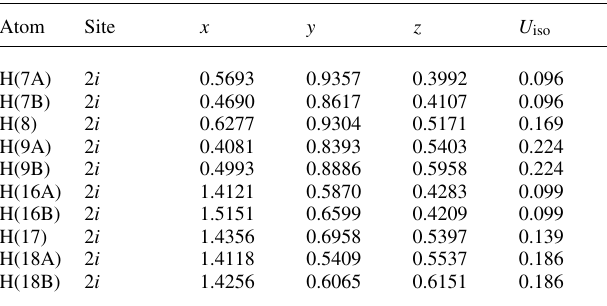
Table 2. Atomic coordinates and displacement parameters (in Å 2 )